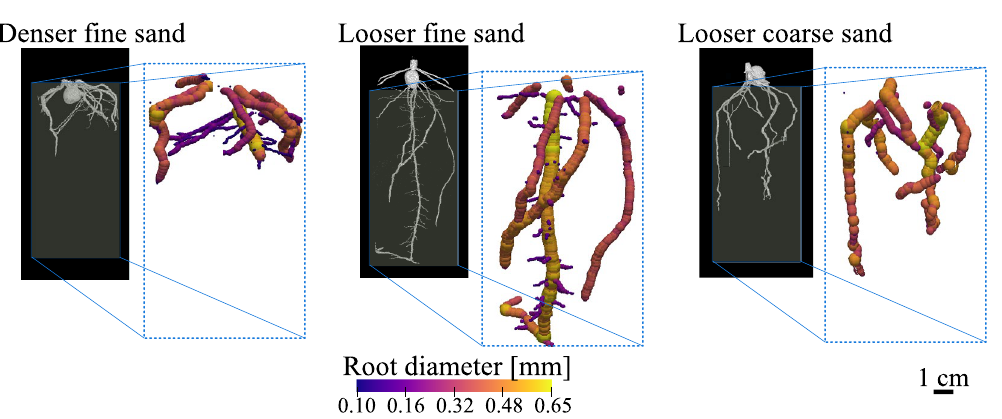
Figure 3. 3D Maize root systems at Day 7 for each soil configuration; the colour-scale figures present the respective distributions of the root cross-section